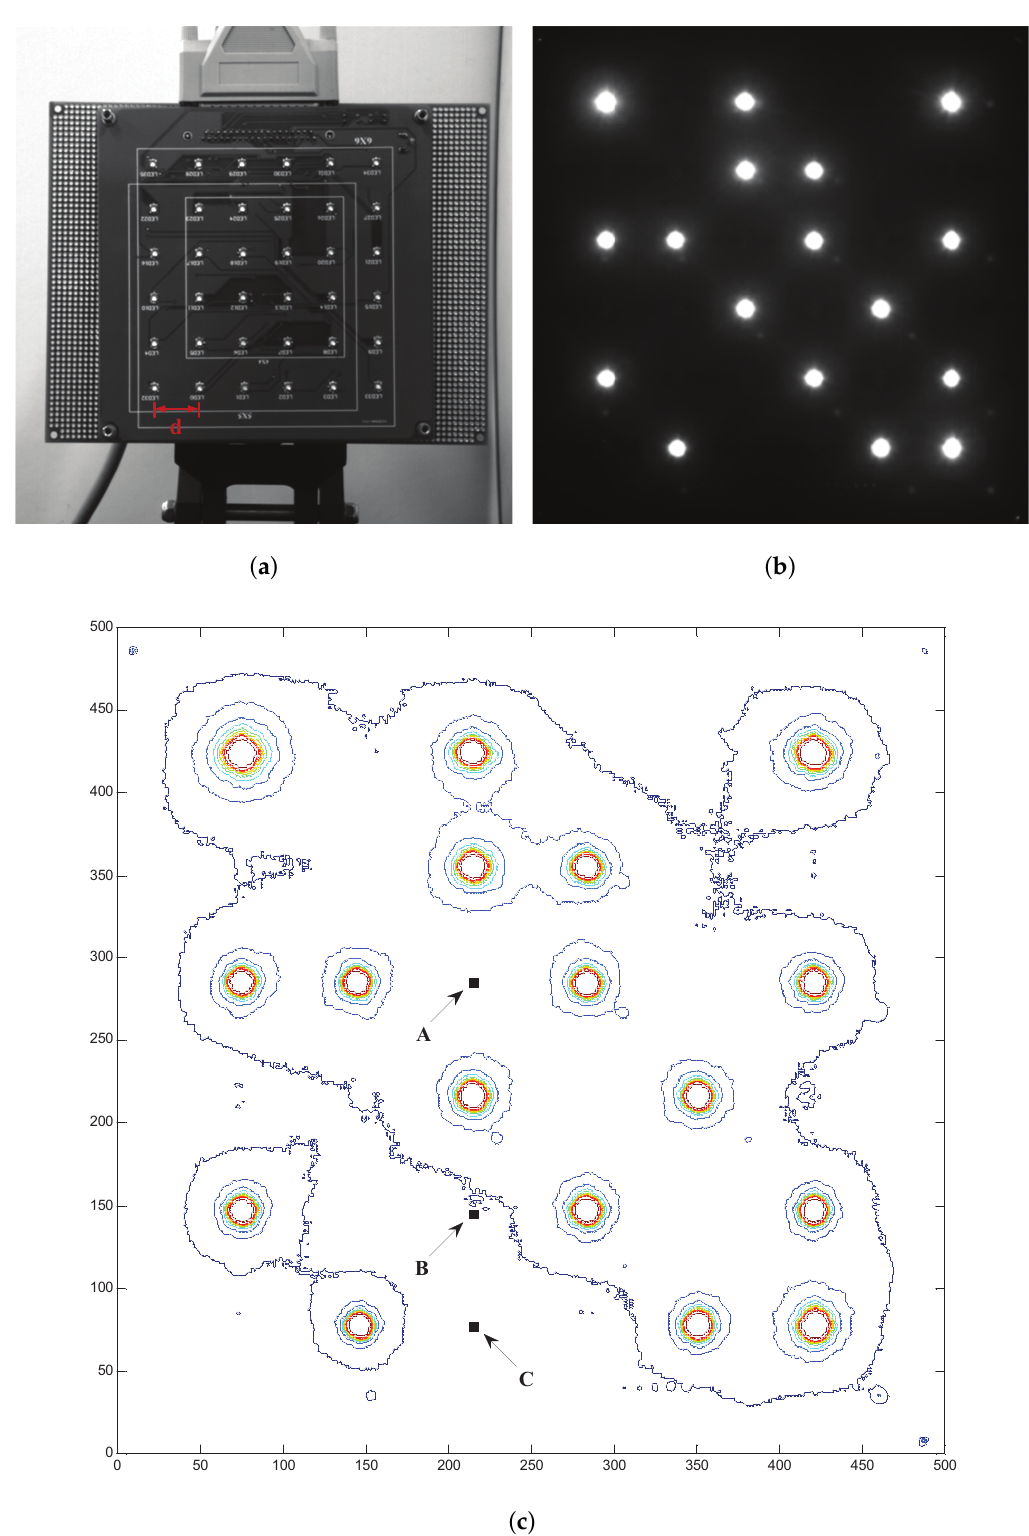
Figure 8. Demonstration of the spatial inter-symbol interference. ( a ) the designed experiment board with 6 × 6 LED array and the LED spacing distance d ; ( b ) imaging result of the LED array; ( c ) light intensity contour plot of ( b